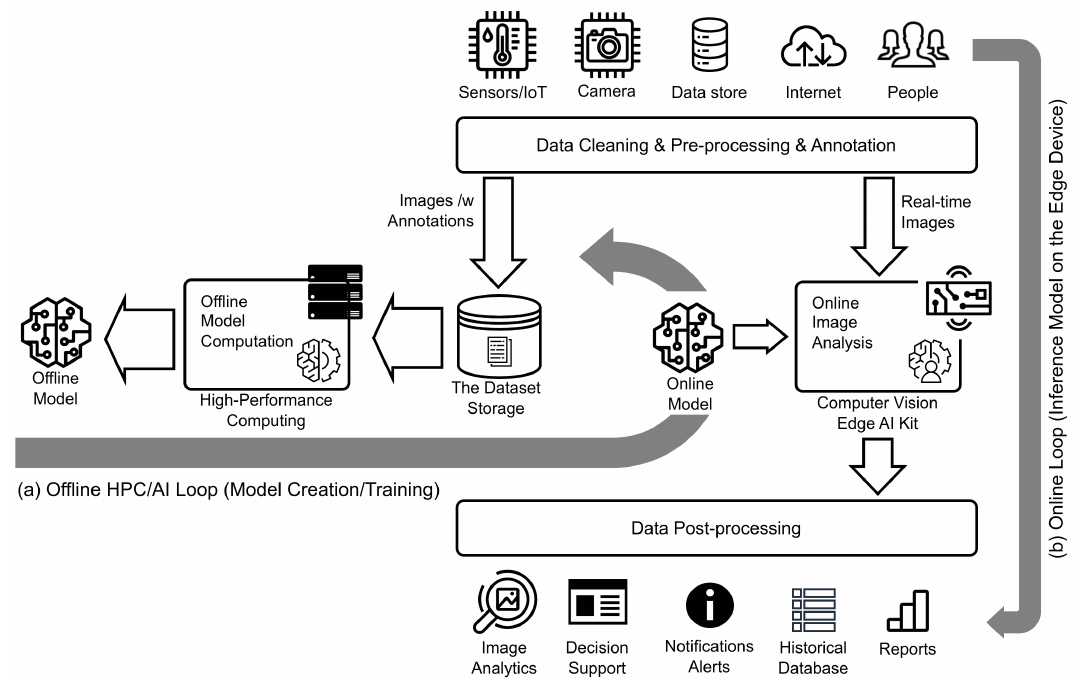
Figure 2. Conceptual approach for the development of computer vision for smart agriculture using HPC and deep learning: ( a ) offline HPC/AI loop: the dataset is used to train and refine prediction models using HPC resources, ( b ) online loop: images captured in the field in real-time processed by trained models ported to the edge AI